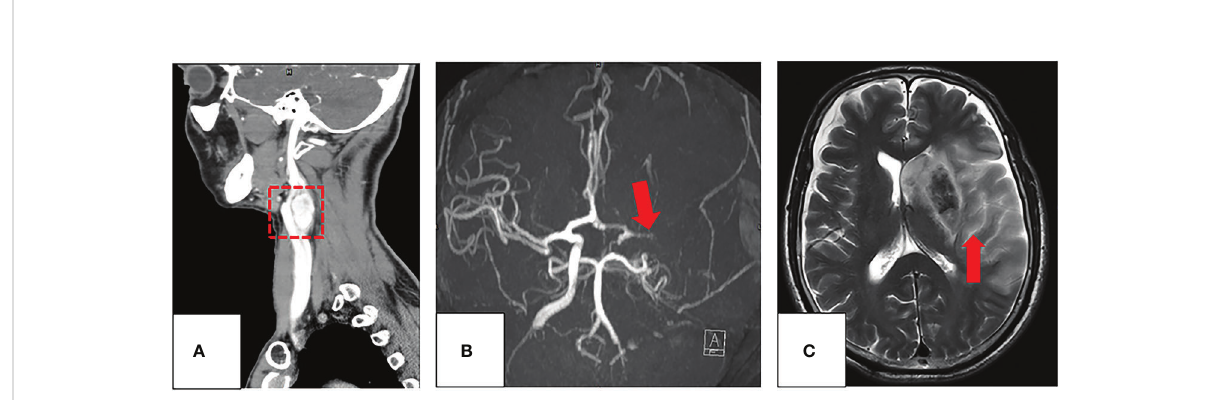
FIGURE 4 (A – C) Imaging evaluation of a 60-year-old patient with a CBT and occlusion of the left ICA post-surgery. (A) The coronal image of the preprocedural CT angiography of CBT (red box). (B) After surgical resection with preoperative embolization of CBT (red arrow), the patient had a sudden right limb weakness. The axial maximum-intensity-projection images from an MRA demonstrate occlusion of the left middle cerebral artery. (C) T 2 WI demonstrates a large acute infarction involving almost all the left middle cerebral artery territory (red arrow).